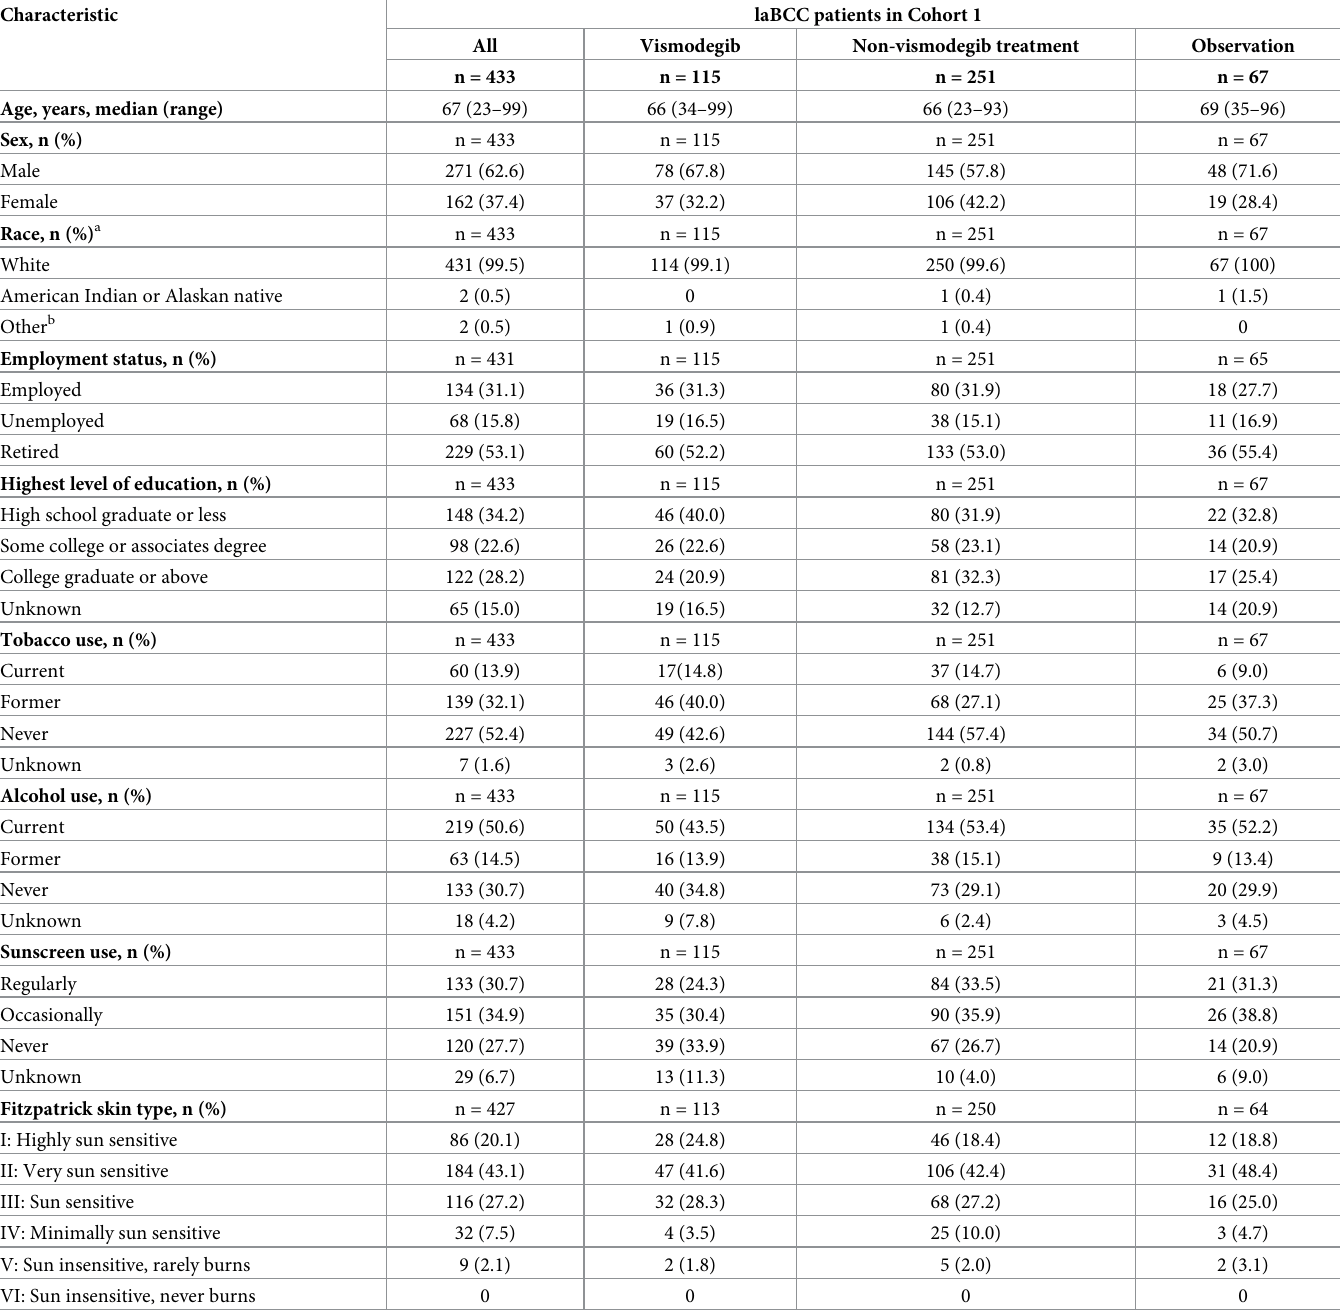
Table 1. Baseline demographics in patients with locally advanced basal cell carcinoma in Cohort 1.